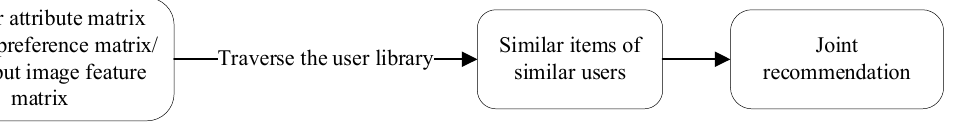
Figure 6. User item joint feature recommendations.